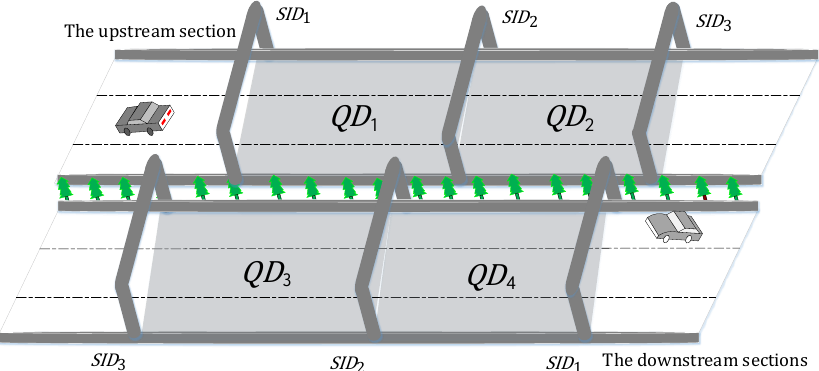
Figure 1. A schematic diagram of the sections.